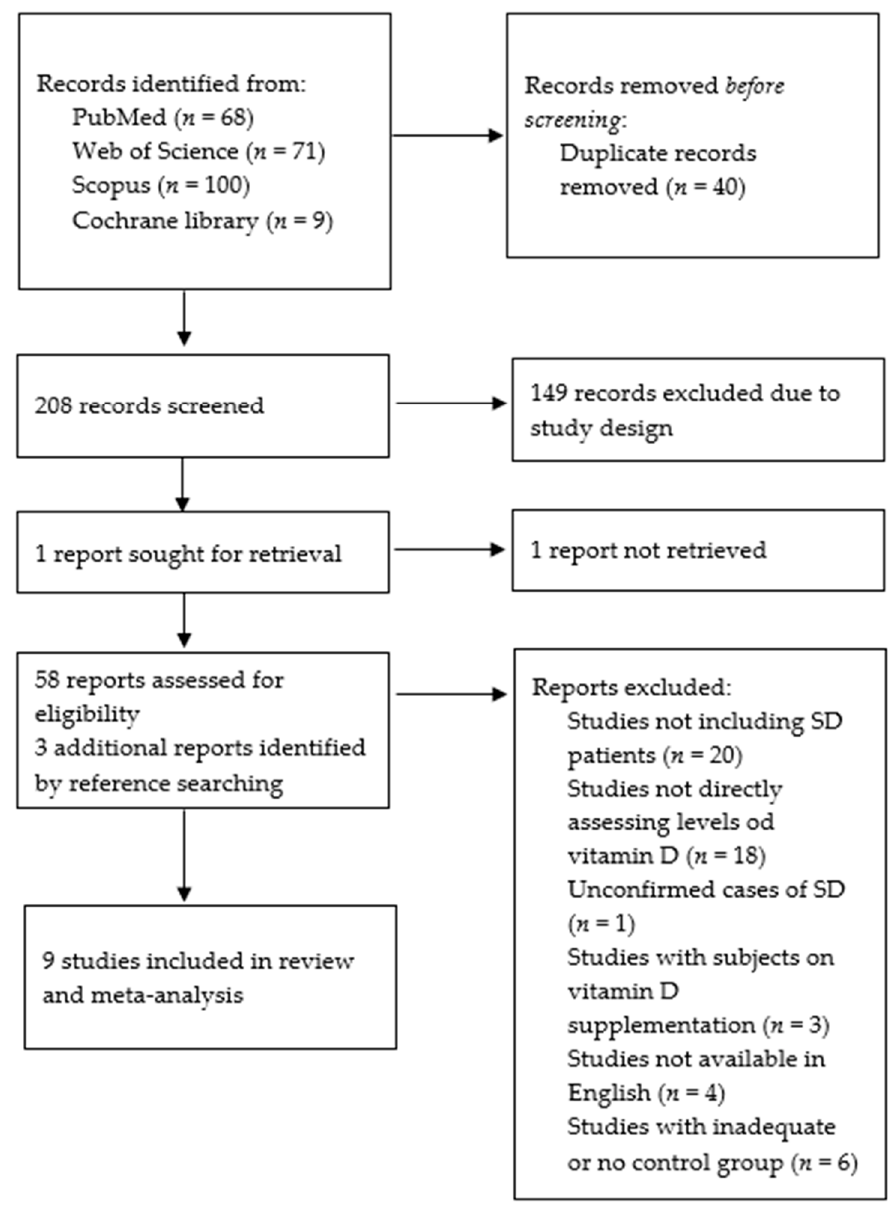
Figure 2. Structural outline of the study selection and exclusion process. Abbreviations: SD— Sjögren’s disease, n —number.